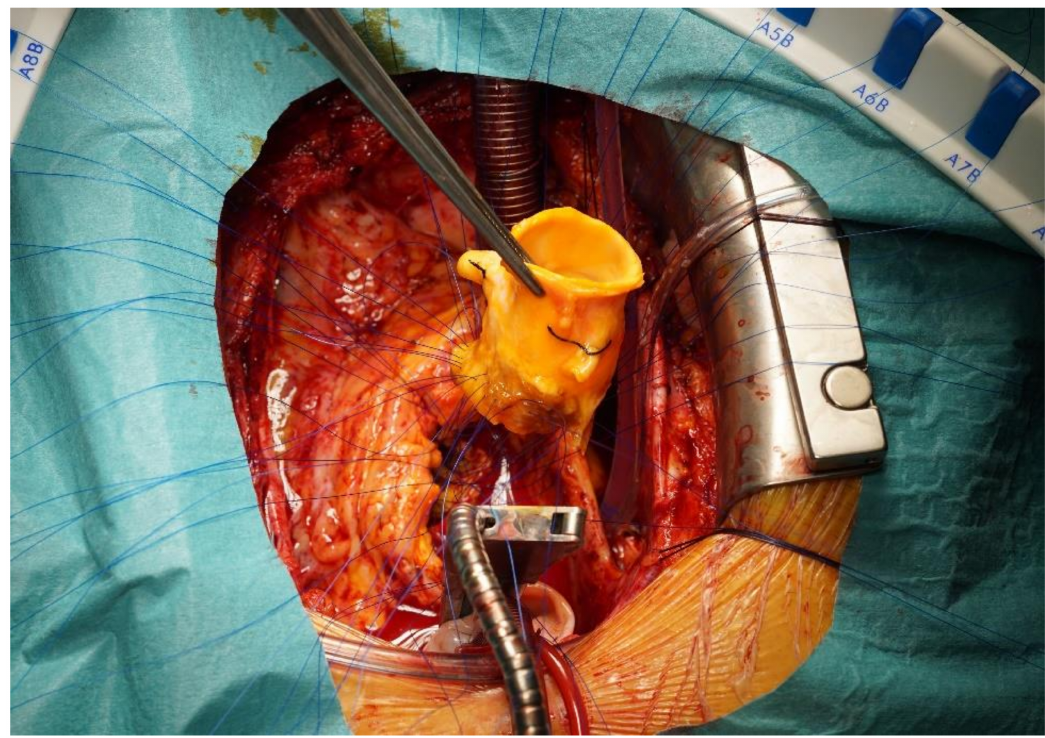
Figure 4. Aortic homograft implantation using polypropylene interrupted